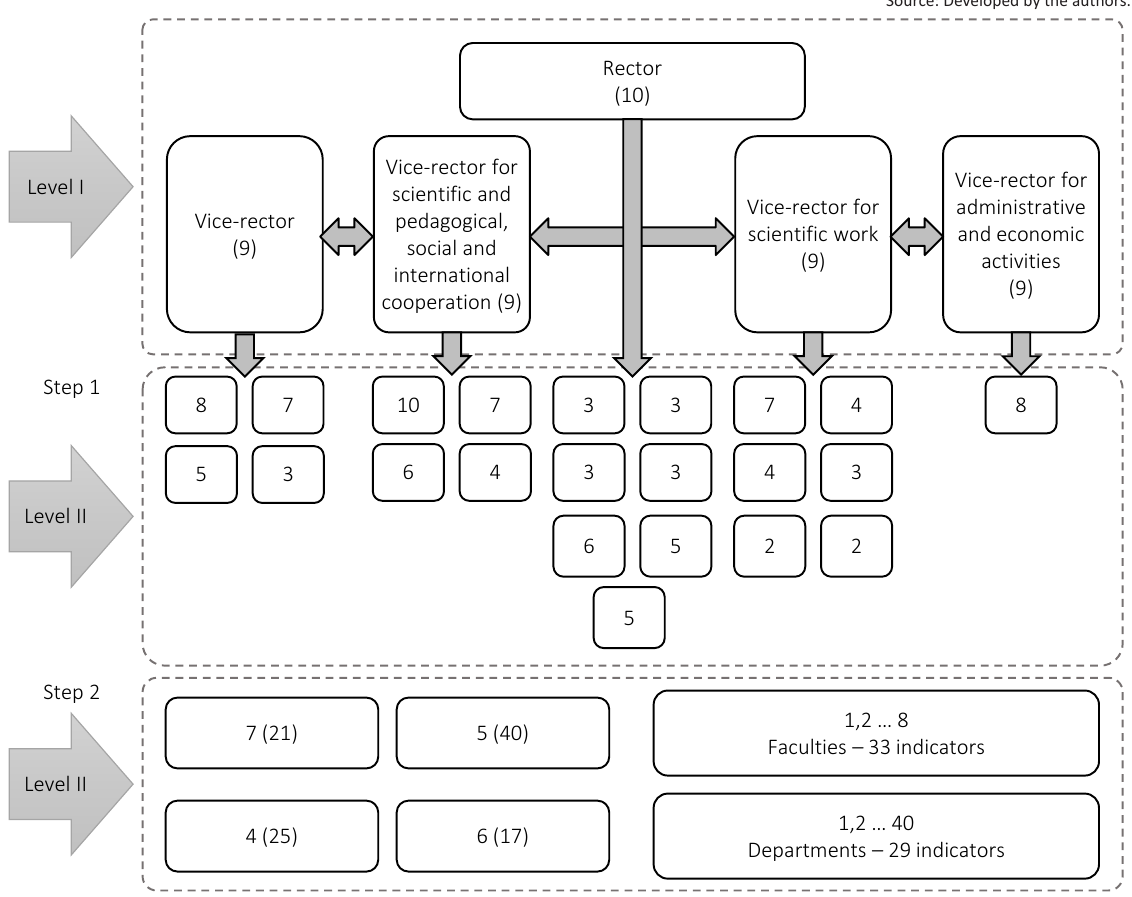
Figure 1. KPI of the university by two steps of their implementation (the number of KPIs of each administrative subdivision is indicated in the blocks of stage 1; the number of subdivisions and in parentheses – the number of KPIs are indicated on stage